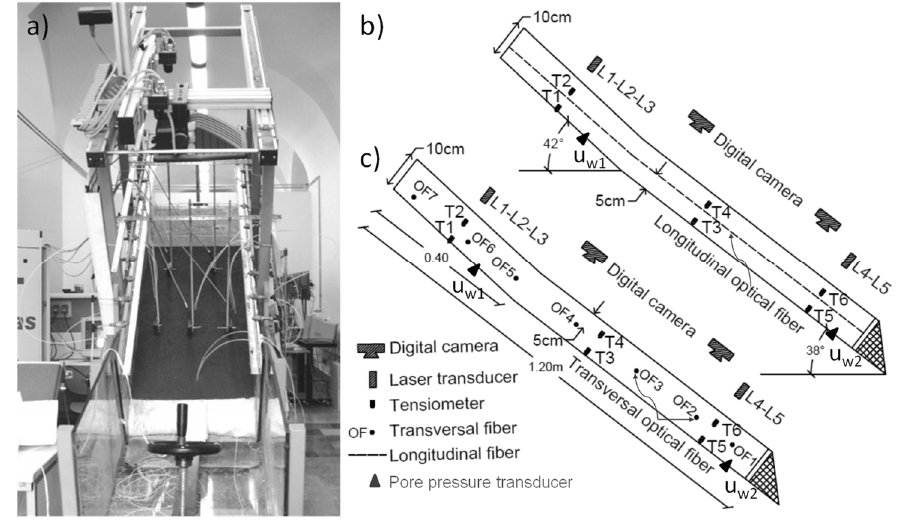
Figure 1. The flume ( a ) and schematic cross sections of the model slopes, with location of the sensors during the RP2 ( b ) and RP3 ( c ) experiments.